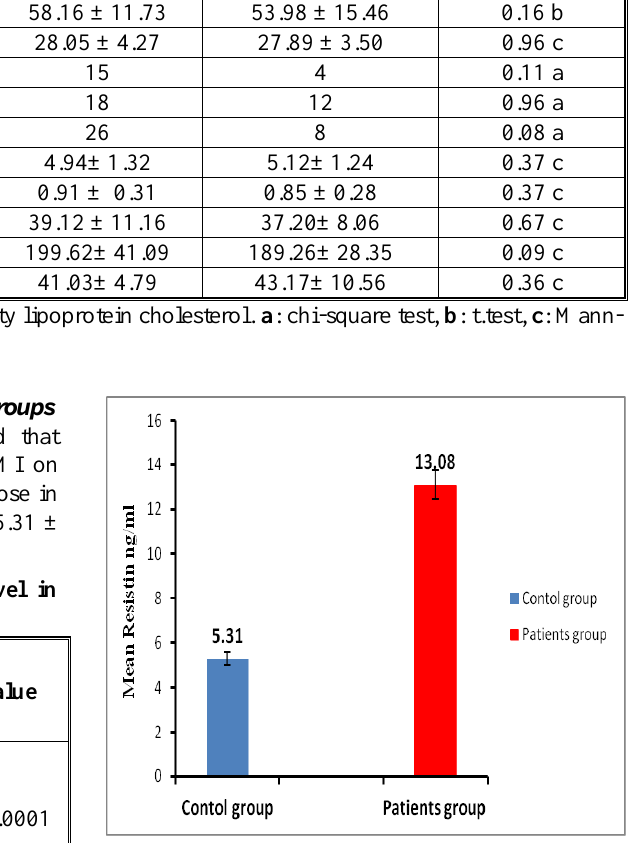
Figure 1: Admission serum resistin level in STEMI patients compared to